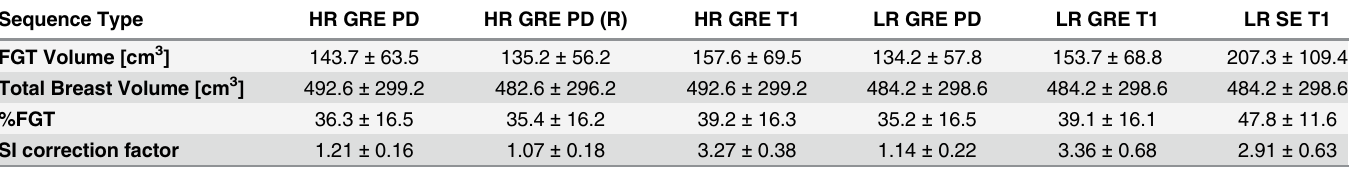
Table 1. Mean and corresponding sample standard deviations for FGT volume, total breast volume and %FGT measured from the different Dixon datasets in 10 volunteers. Also shown are the mean and corresponding sample standard deviations of the calculated signal intensity correction factors applied to each sequence.